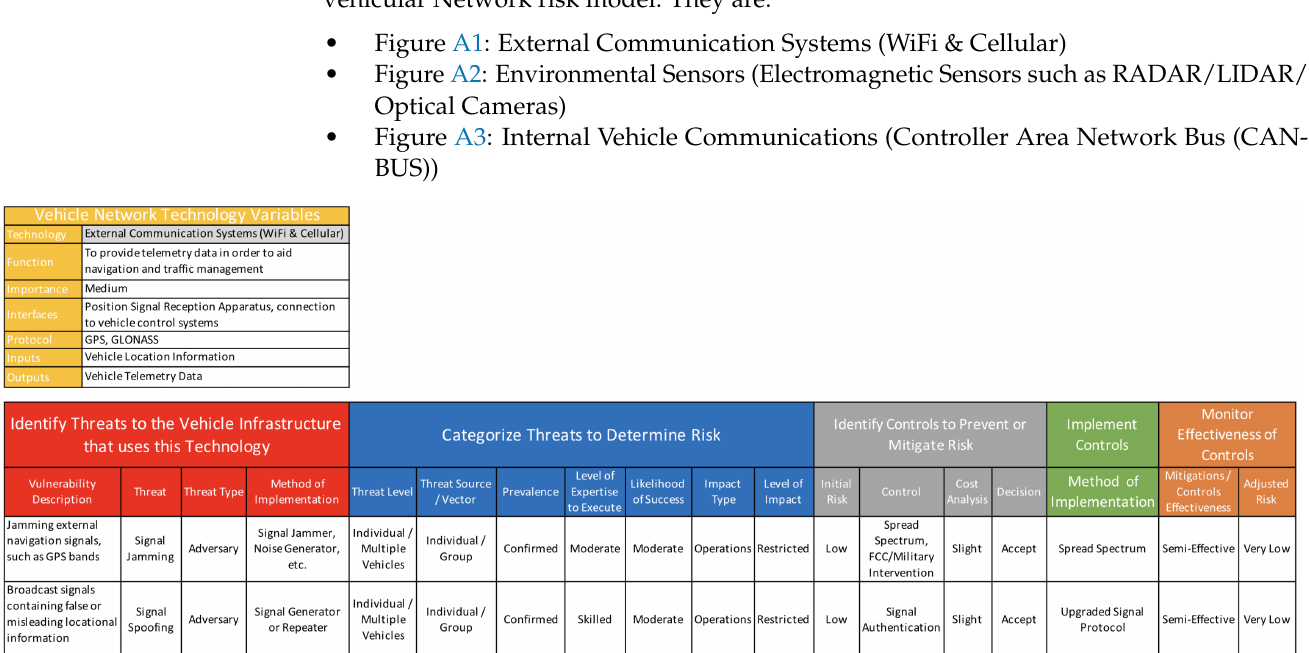
Figure A1. Vehicular Network Risk Management Process Example for External Communication Systems (WiFi &